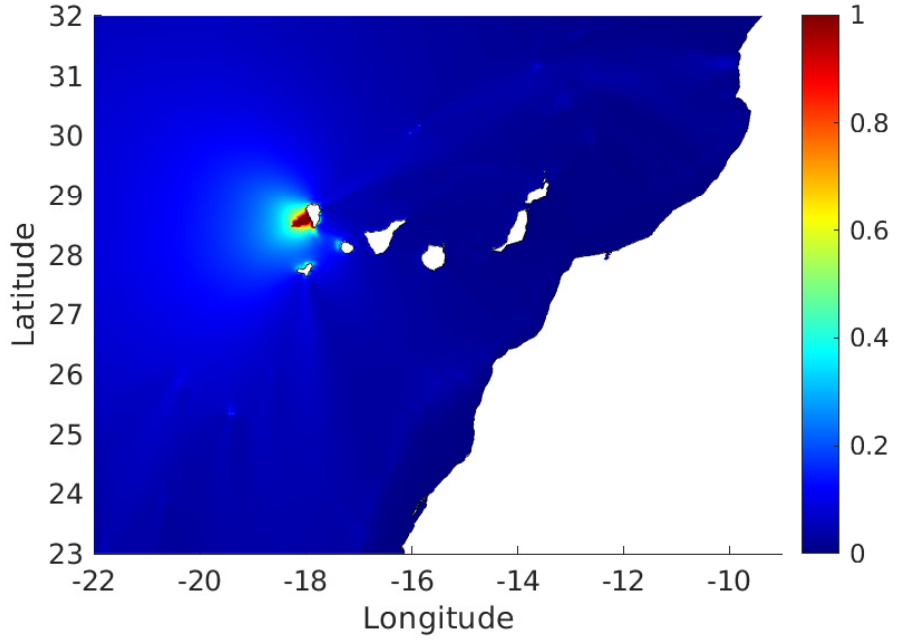
Figure 8. Calculated maximum wave heights (m) for a 0.13 km 3 submarine